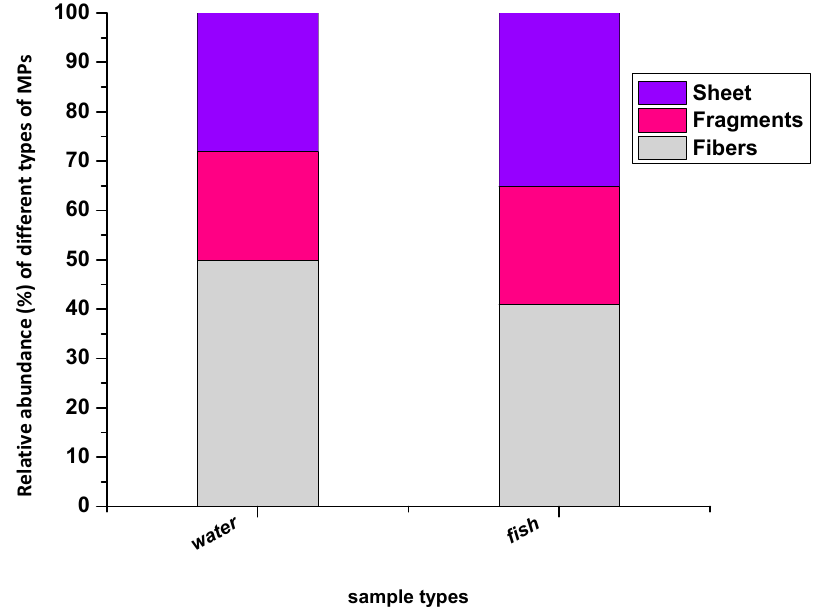
Figure 4. Relative abundance of three major particle shapes of the identified MPs recovered from the surface water and fish GIT samples.